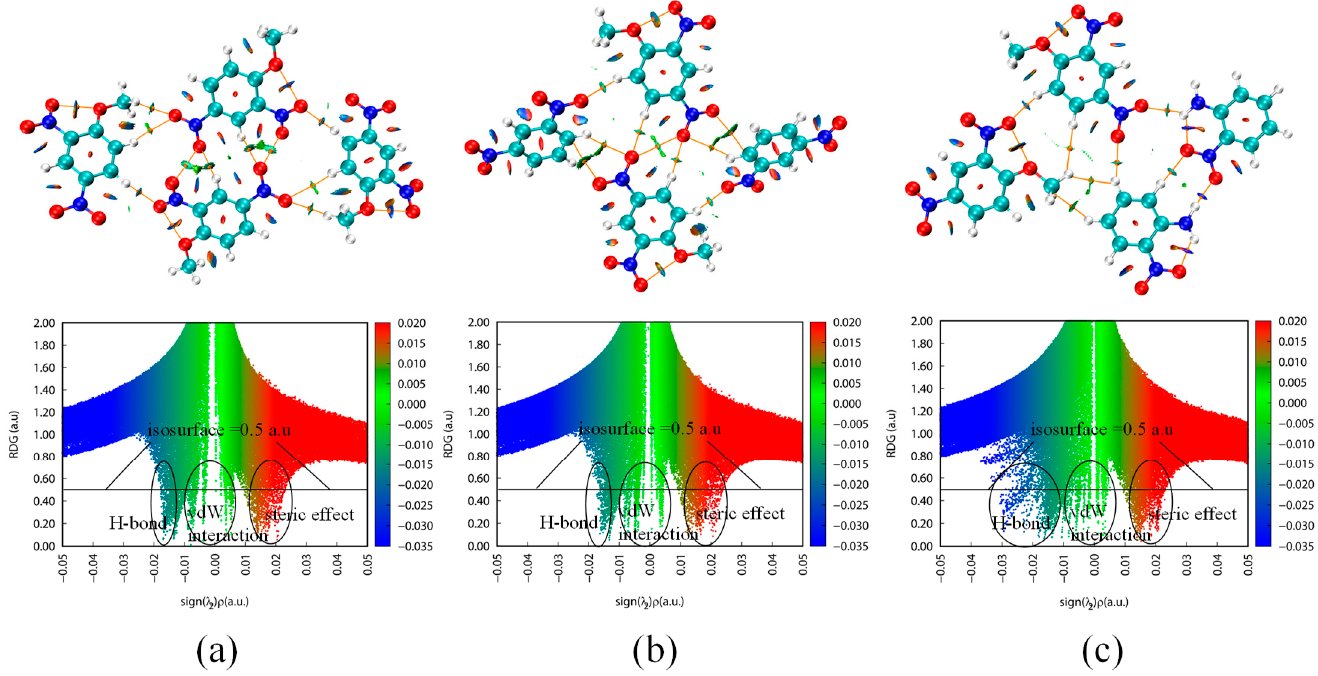
Figure 4. RDG isosurface diagrams ( top row), scatter plot (the isovalue is 0.5 a.u., bottom row), and AIM analysis in the crystals DNAN ( a ), DNAN/DNB ( b ), and DNAN/NA ( c ). Blue, green, and red represent H-bond, vdW interaction, and steric effect, respectively. Orange circles and lines denote BCP and critical paths in the AIM analysis, respectively.